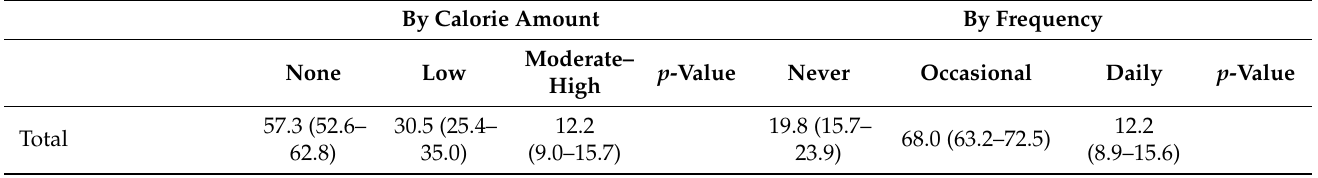
Table 5. Behavioral and social factors related to the different SSBs consumption patterns for women. By Calorie Amount By Frequency None Low